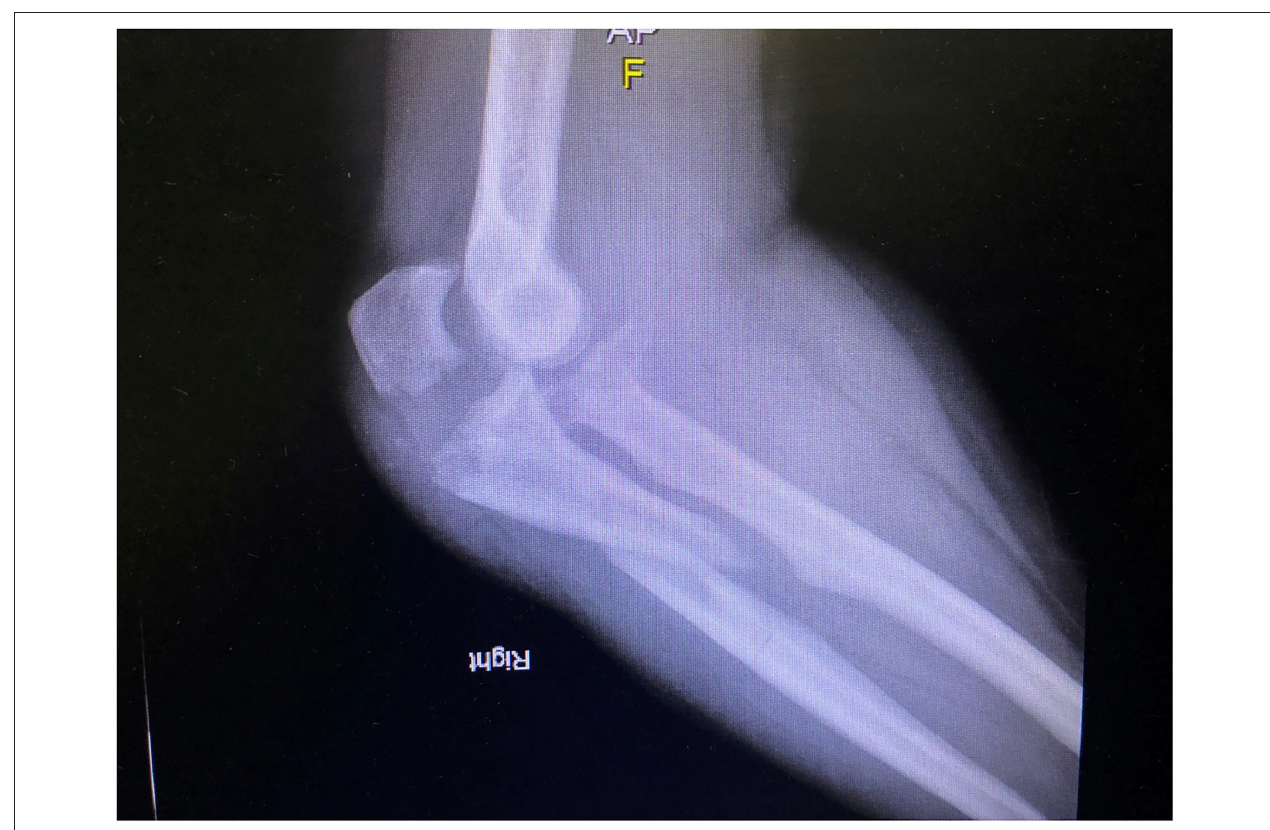
FIGURE 2 | Preoperative elbow lateral view of a complex elbow